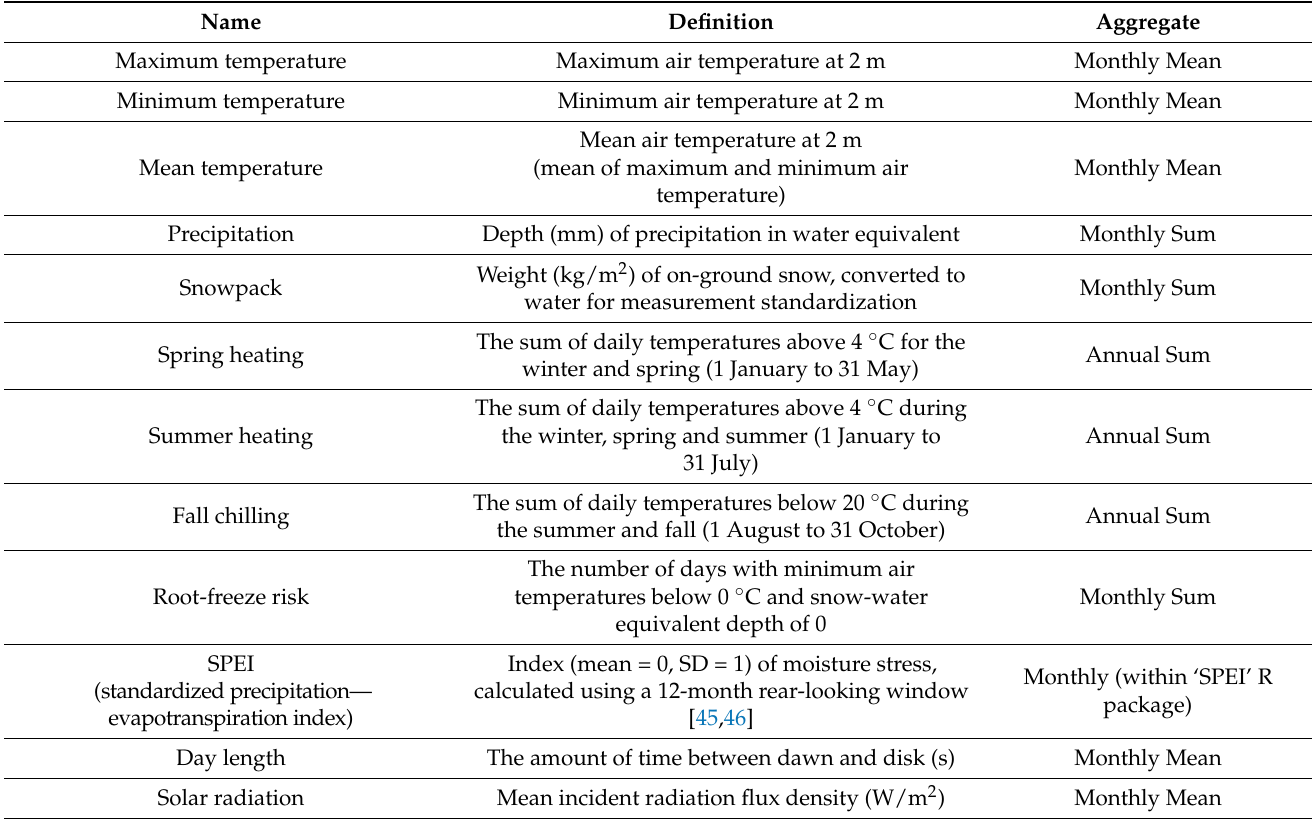
Table 2. Climatic variables used as independent variables in forest-climate models, their definitions, and their temporal resolution following aggregation from a base daily